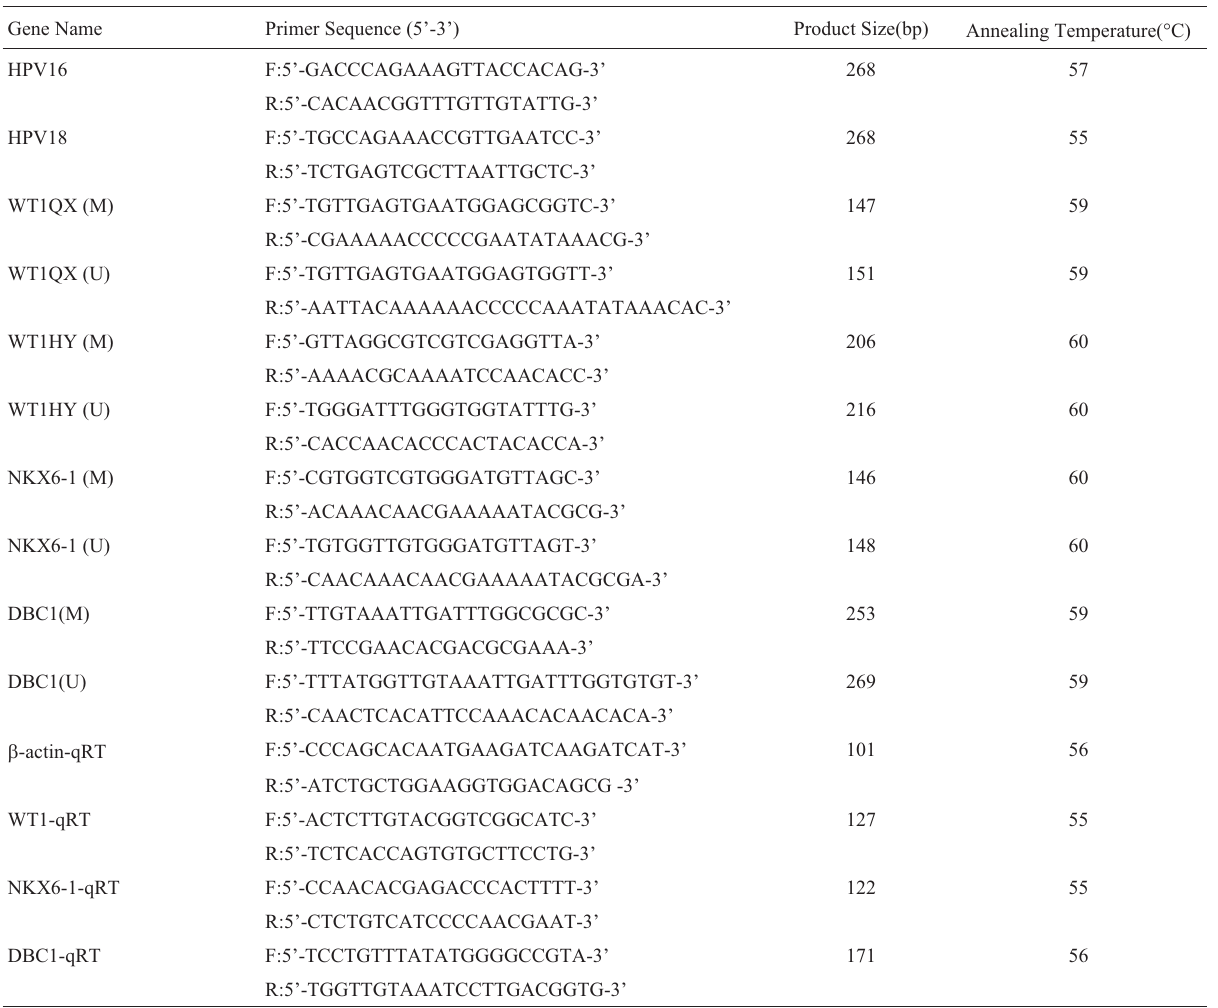
Table 1 - Primer sequences for PCR analysis.